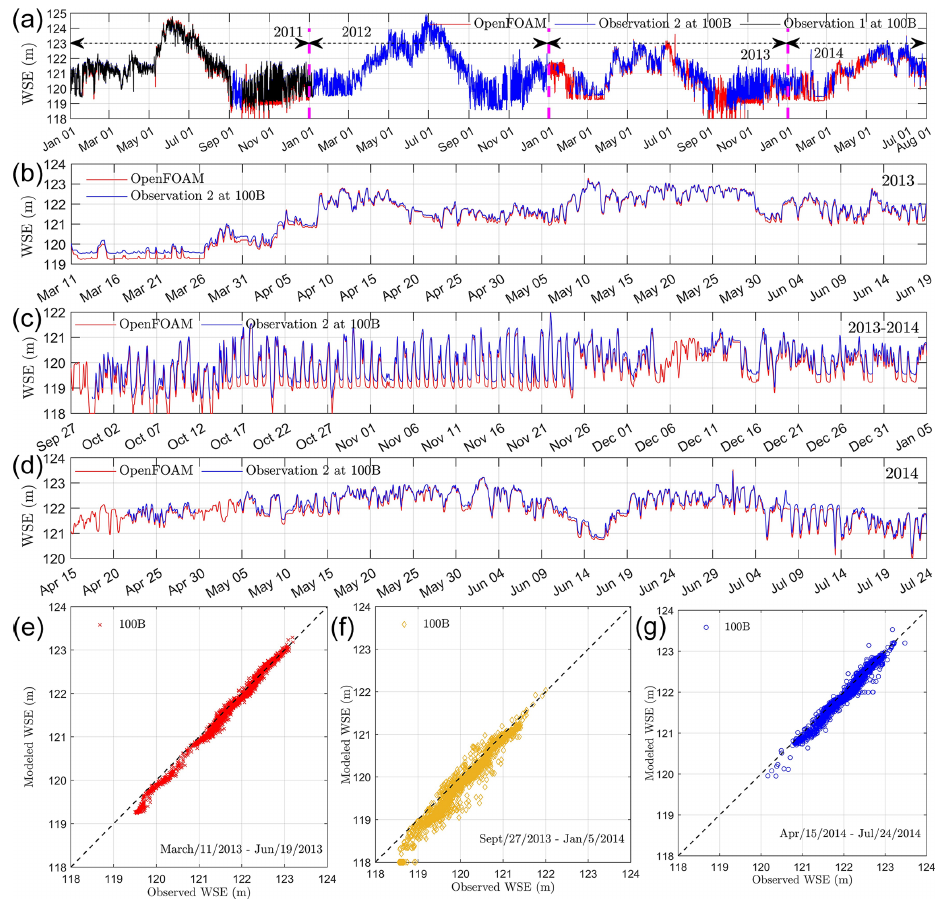
Figure 9. Medium-term model validation for water surface elevation. A comparison of hourly recorded WSE from model and observations during 2011–2014 (a) , medium flow (b) , low flow (c) , and high flow (d) . Panels (e) – (g) denote the 1 : 1 plot during medium-, low-, and high-flow scenarios.